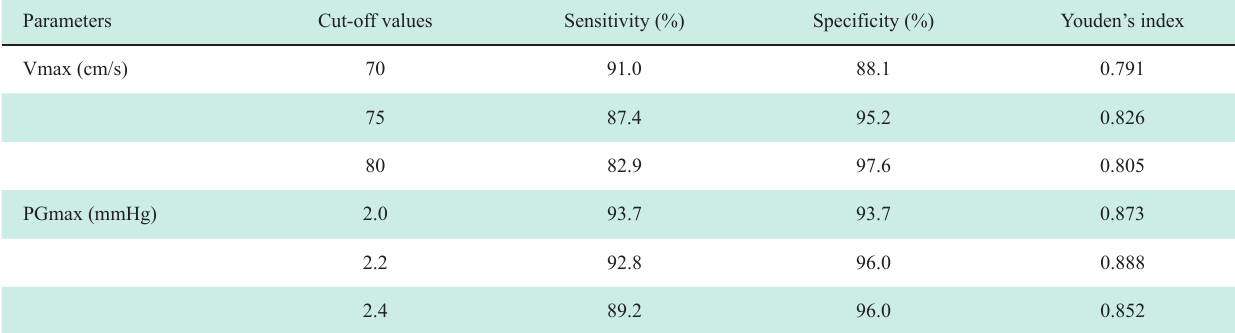
Table 5 The cut-off values of Vmax and PGmax at the stenosis site for determining IJV regional stenosis Parameters Cut-off values Sensitivity (%)